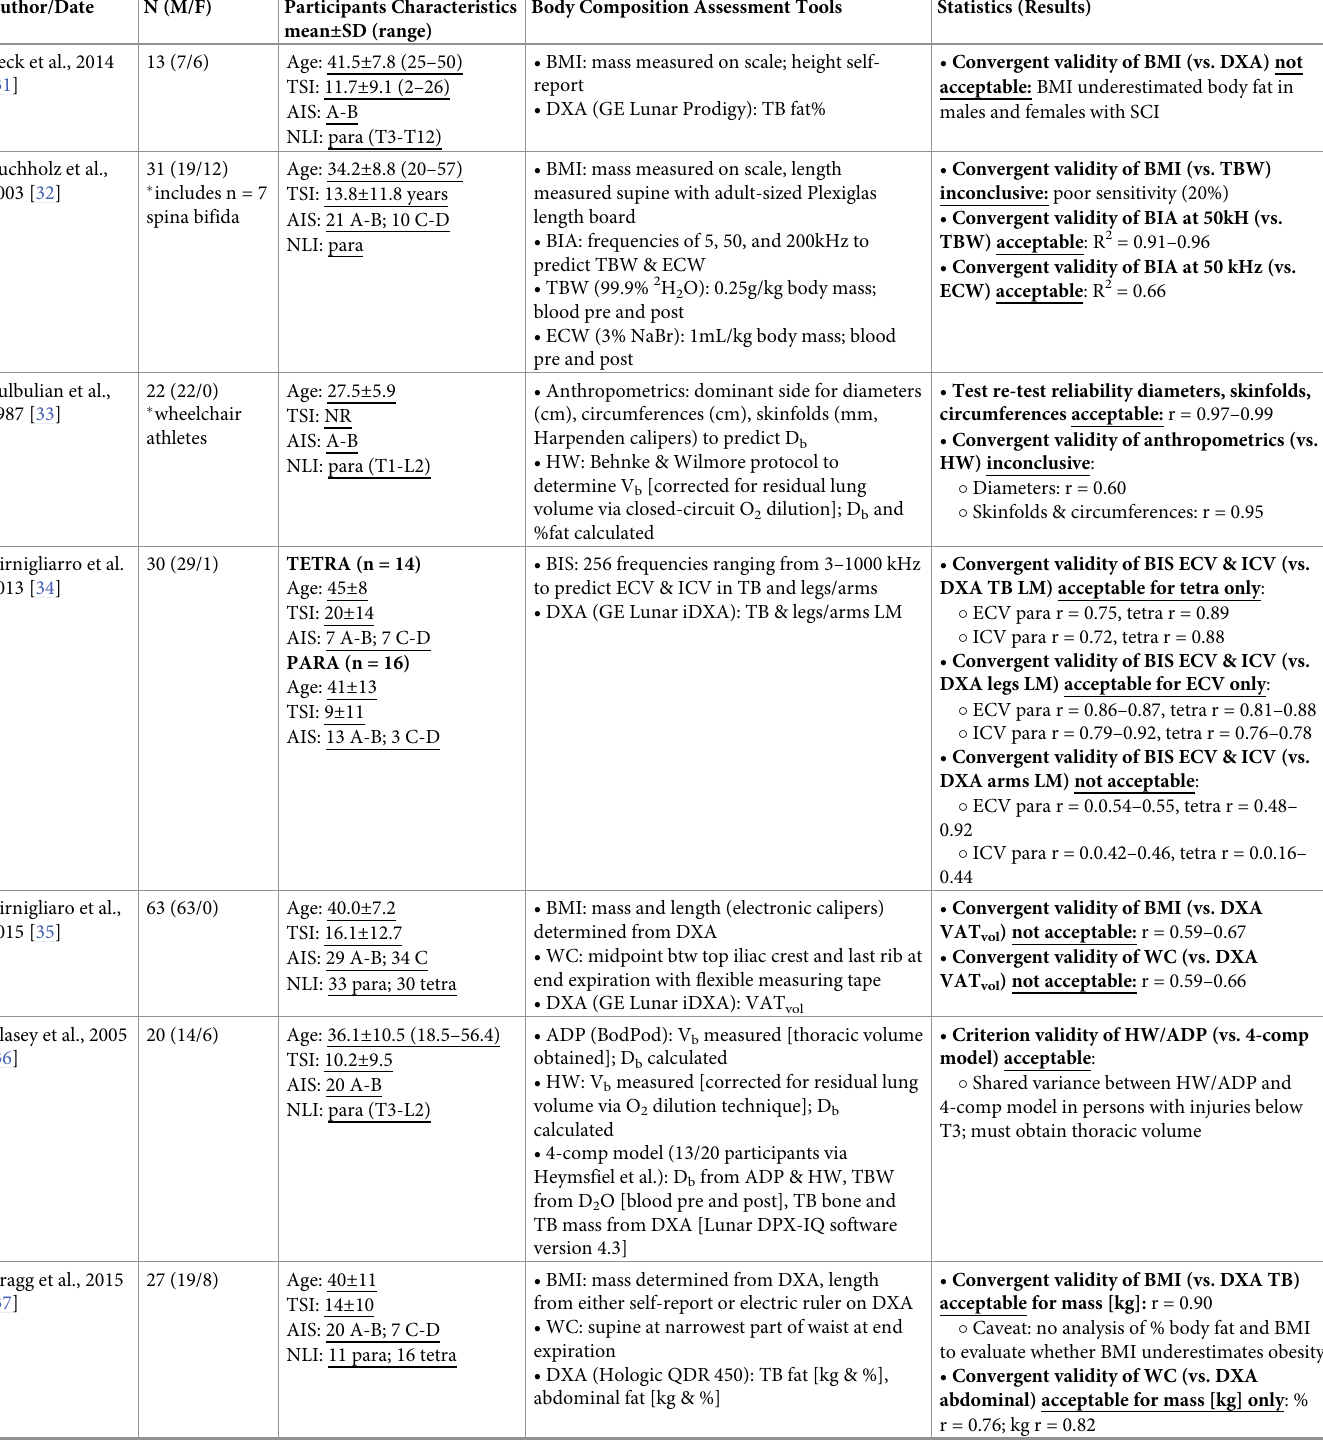
Table 2. Data charting (extraction) of eligible studies in alphabetical order by first